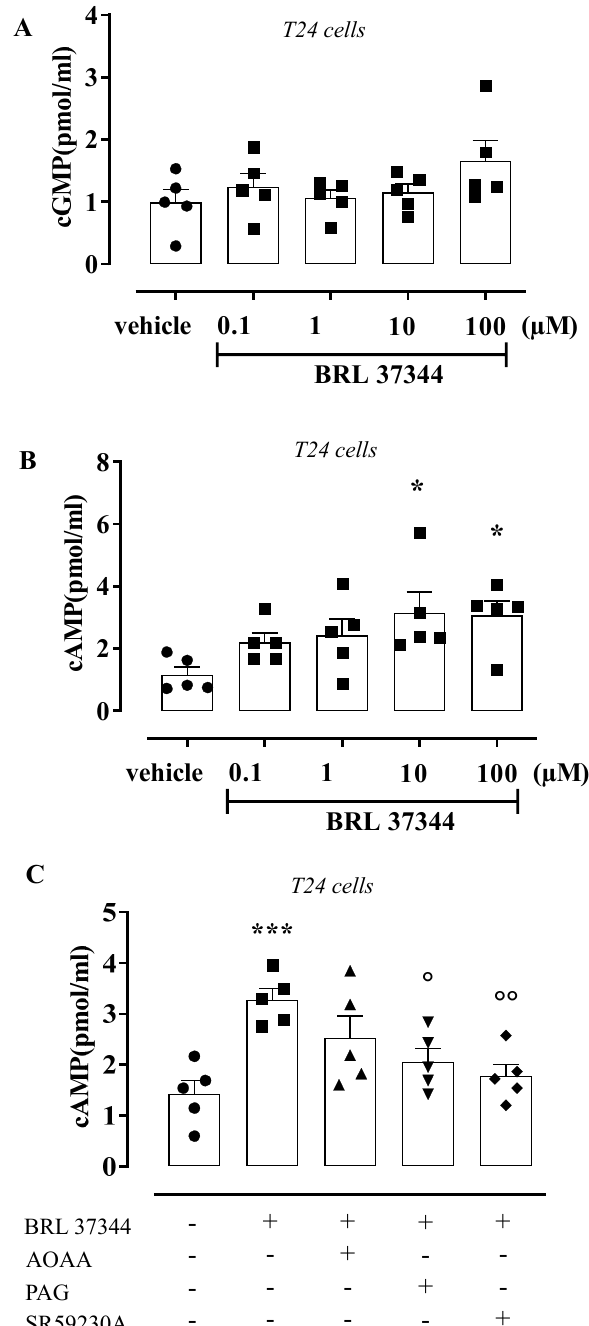
Figure 5. Effect of BRL 37344 on cGMP and cAMP content in T24 cells. ( A ) BRL 37344 (0.1–100 µM) did not modify cGMP content compared to vehicle in T24 cells. ( B ) BRL 37344 (0.1–100 µM) increased the cAMP content 2.7 times compared to vehicle in T24 cells (* p < 0.05). ( C ) PAG (10 mM) and SR59230A (10 µM), but not AOAA (1 mM), reduced the BRL 37344 (1 µM)-induced cAMP content (*** p < 0.001 vs. vehicle; ° p < 0.05 and °° p < 0.01 vs. BRL 37344) 0.63- and 0.54-fold.